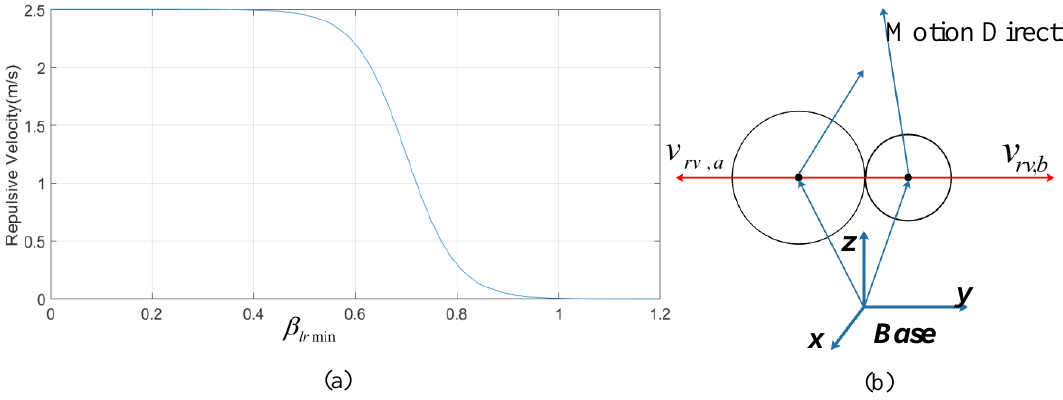
Figure 5. ( a ) Relationship between minimal sensitivity index and repulsive velocity. ( b ) The repulsive velocity produced at the center of the spherical volumes.